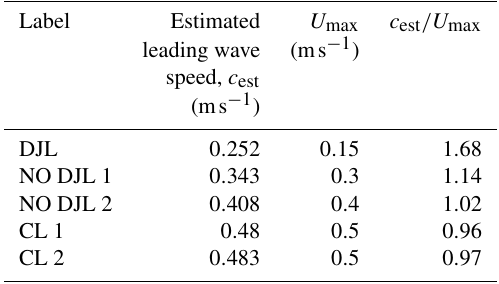
Table 2. Estimated wave speeds for select cases.